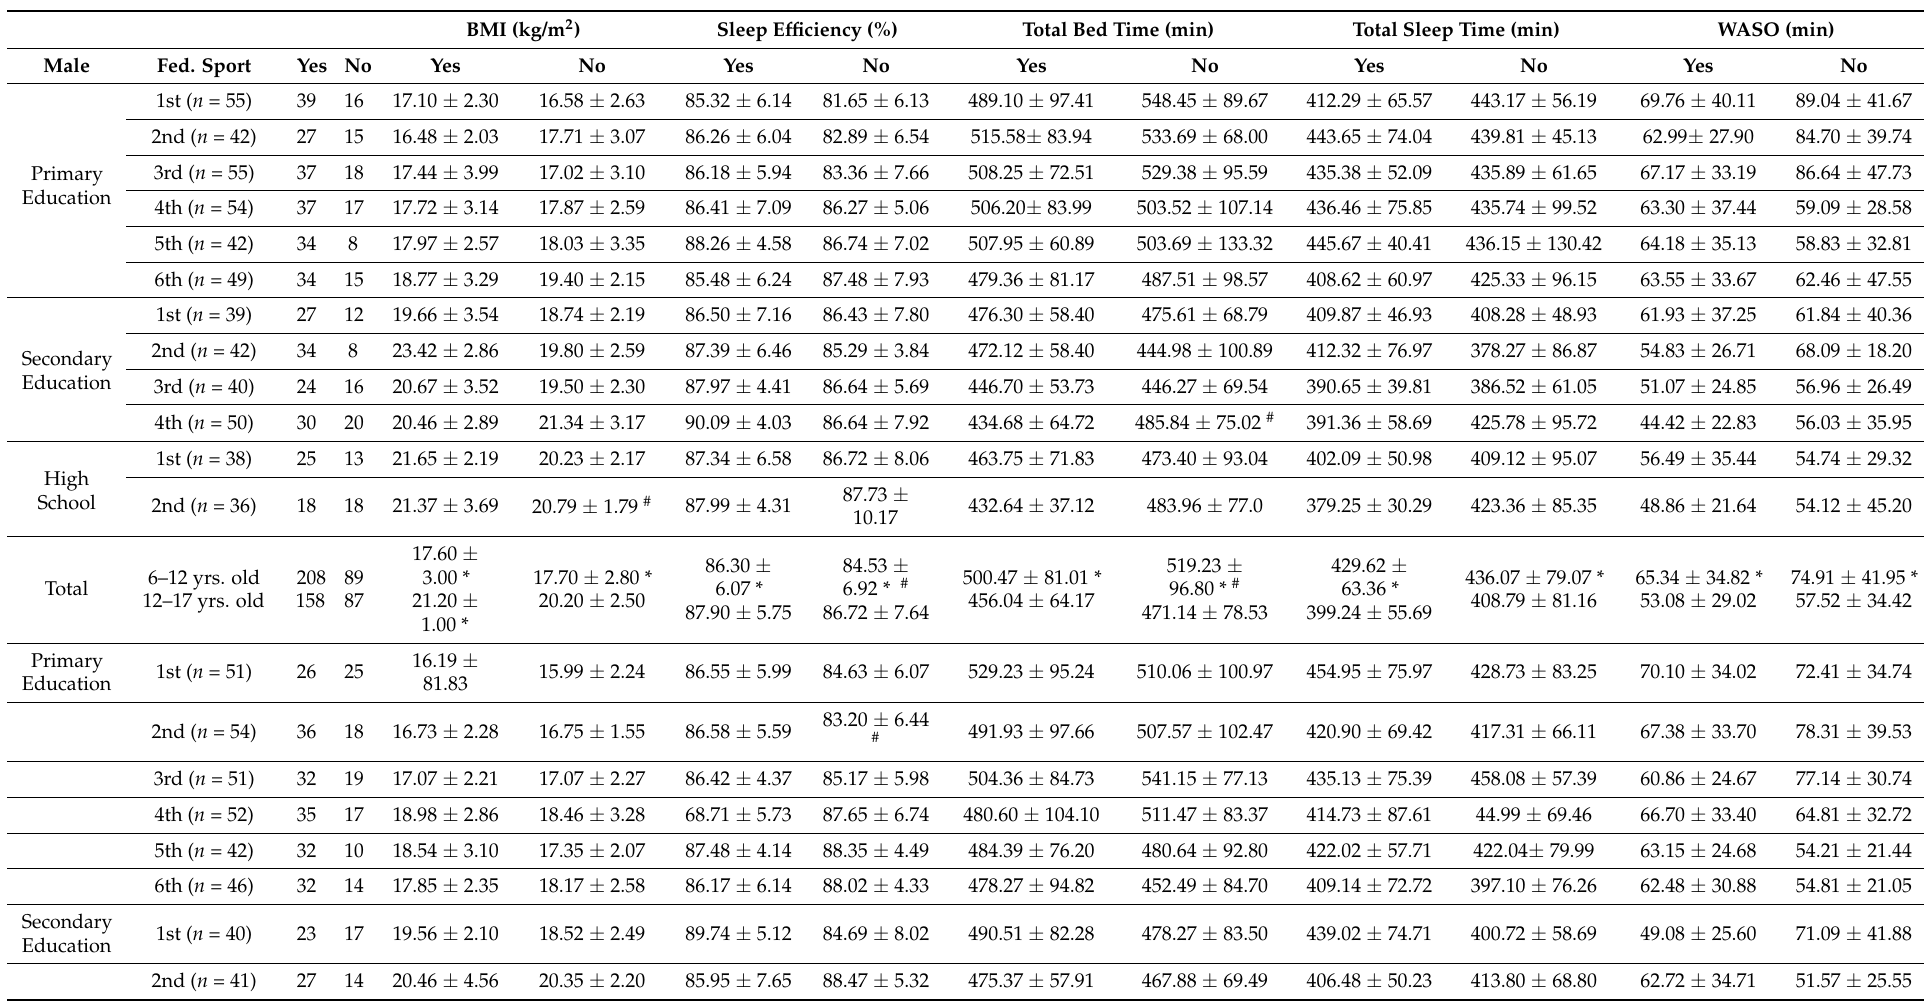
Table 4. Results of daily sleep quality analysis in each of the school years between practitioners and nonpractitioners of organised/federated sports in each